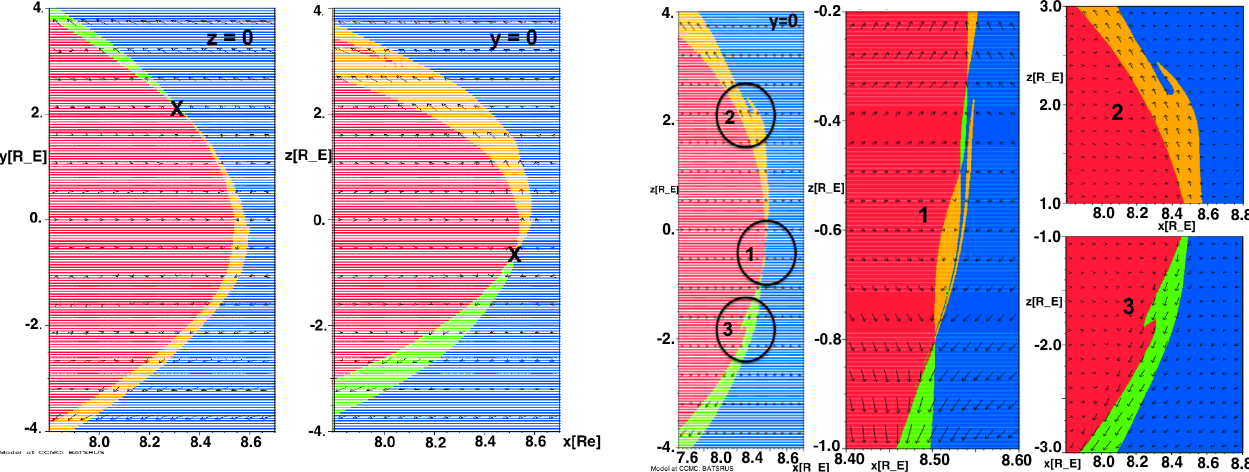
Fig. 18. Magnetic topology after the interlinked flux tubes had prop- agated northward, at t = 7min, for the noon-midnight plane ( y = 0, first plot), showing the numbered magnetic structures (1, 2, 3) dis- played on a larger scale on the other three plots. Colors are related to magnetic topology as red, closed; yellow, connected to north; green, connected to south; and blue, solar wind. Arrows indicate flow